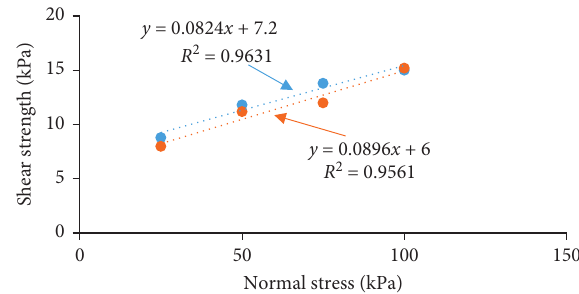
Figure 11: Shear strength versus normal stress in interface fric- tional behavior tests.